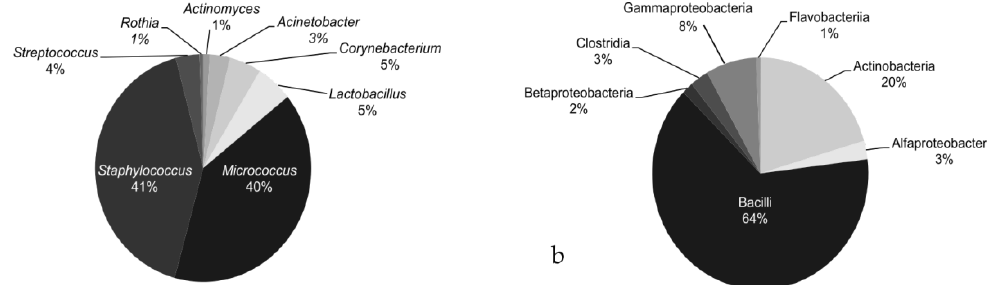
Figure 1. Bacteria recovered through microbiological environmental monitoring (MEM) after 32 meetings: ( a ) potentially human-derived bacterial genera; ( b ) truly environmental bacterial classes.